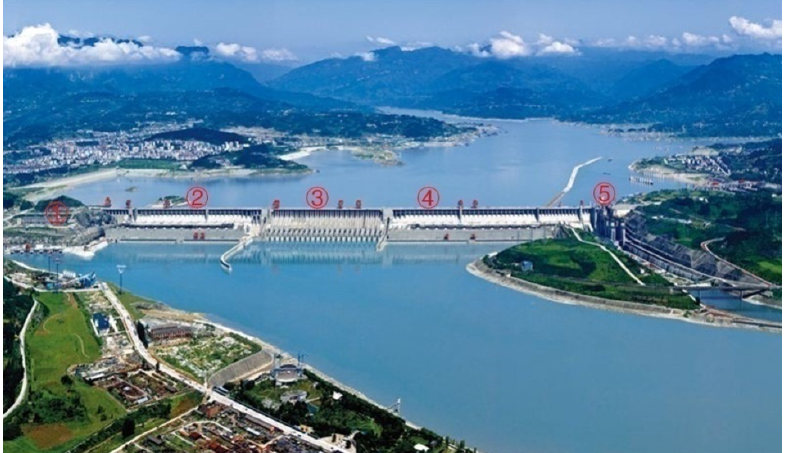
Figure 5. Overall view of the Three Gorges Project. The underground powerhouse is inside a small mountain named Baiyanjian, and the top elevation of the mountain is 243 m. The underground powerhouse is 240 m long,